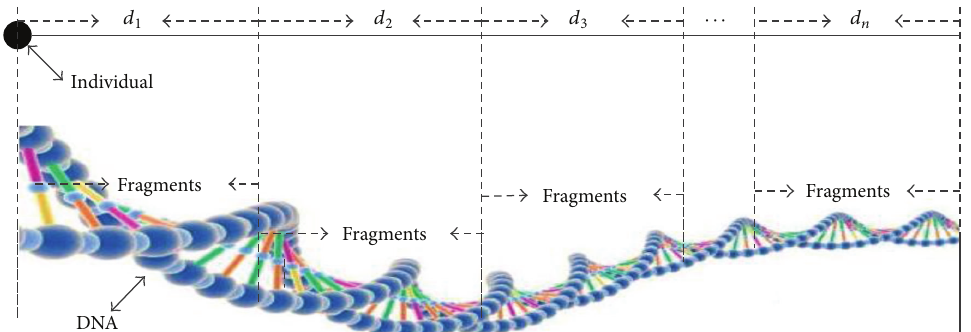
Figure 1: Relationship between DNA fragment and individual.